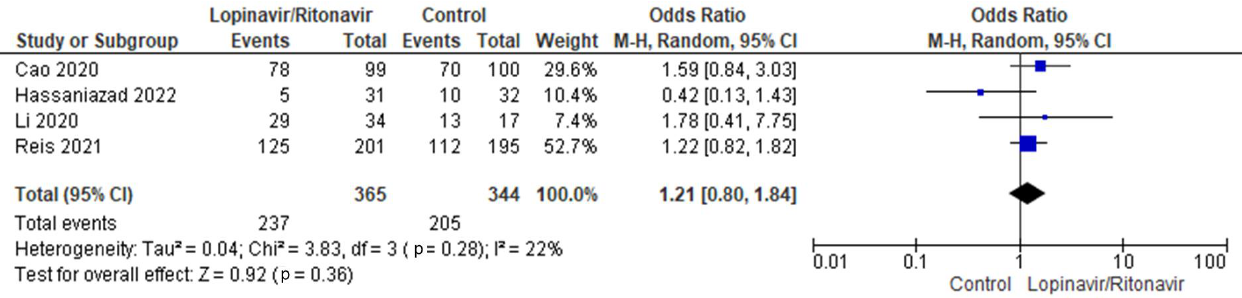
Figure 3. Forest plot analysis for mortality incidence. The sizes of the blue squares reflect the relative weight of the individual trials. The combined point estimate is shown as a black diamond. The dia- mond and the squares (together with the 95% CIs) located beyond the vertical line (indicating the unit value) show that a result was statistically significant.